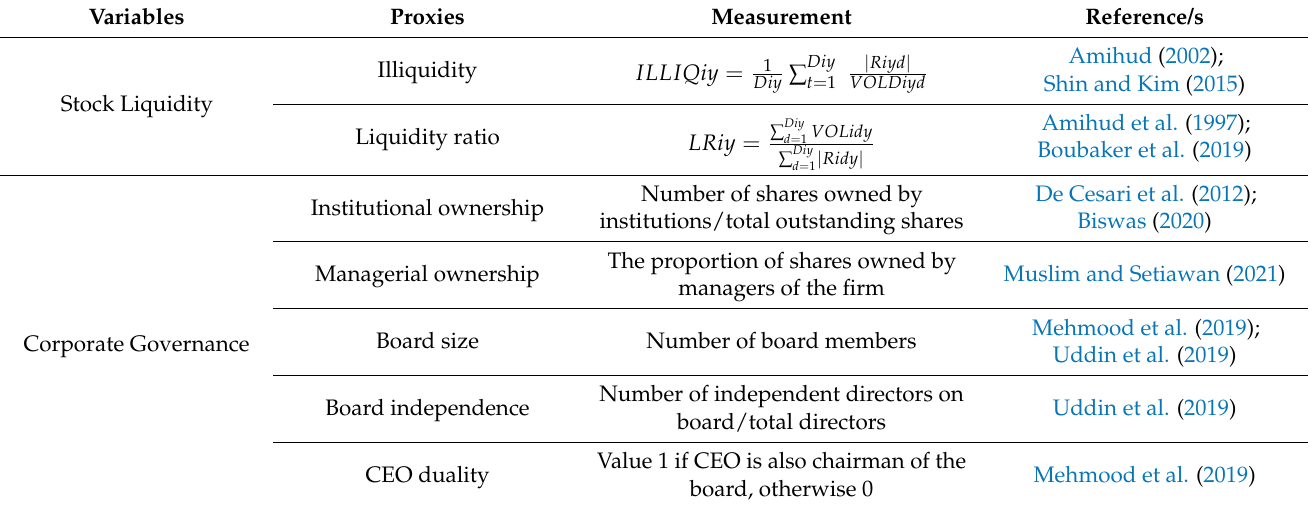
Table 1. Description and measurement of